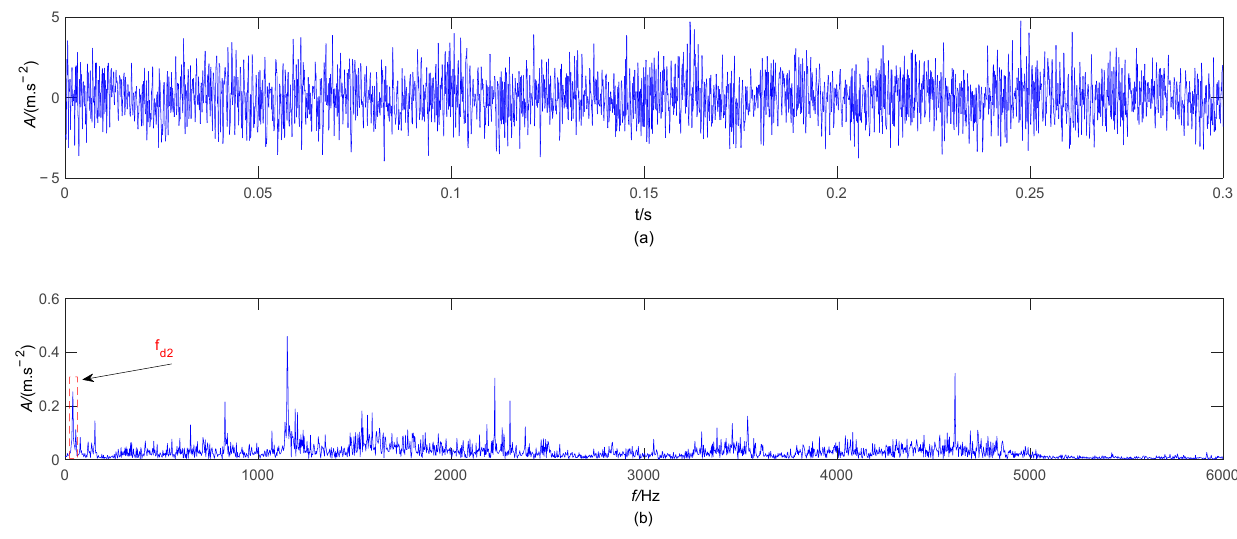
Figure 9. Original signal of ER-16K ( a ) time domain curve ( b ) frequency domain curve.